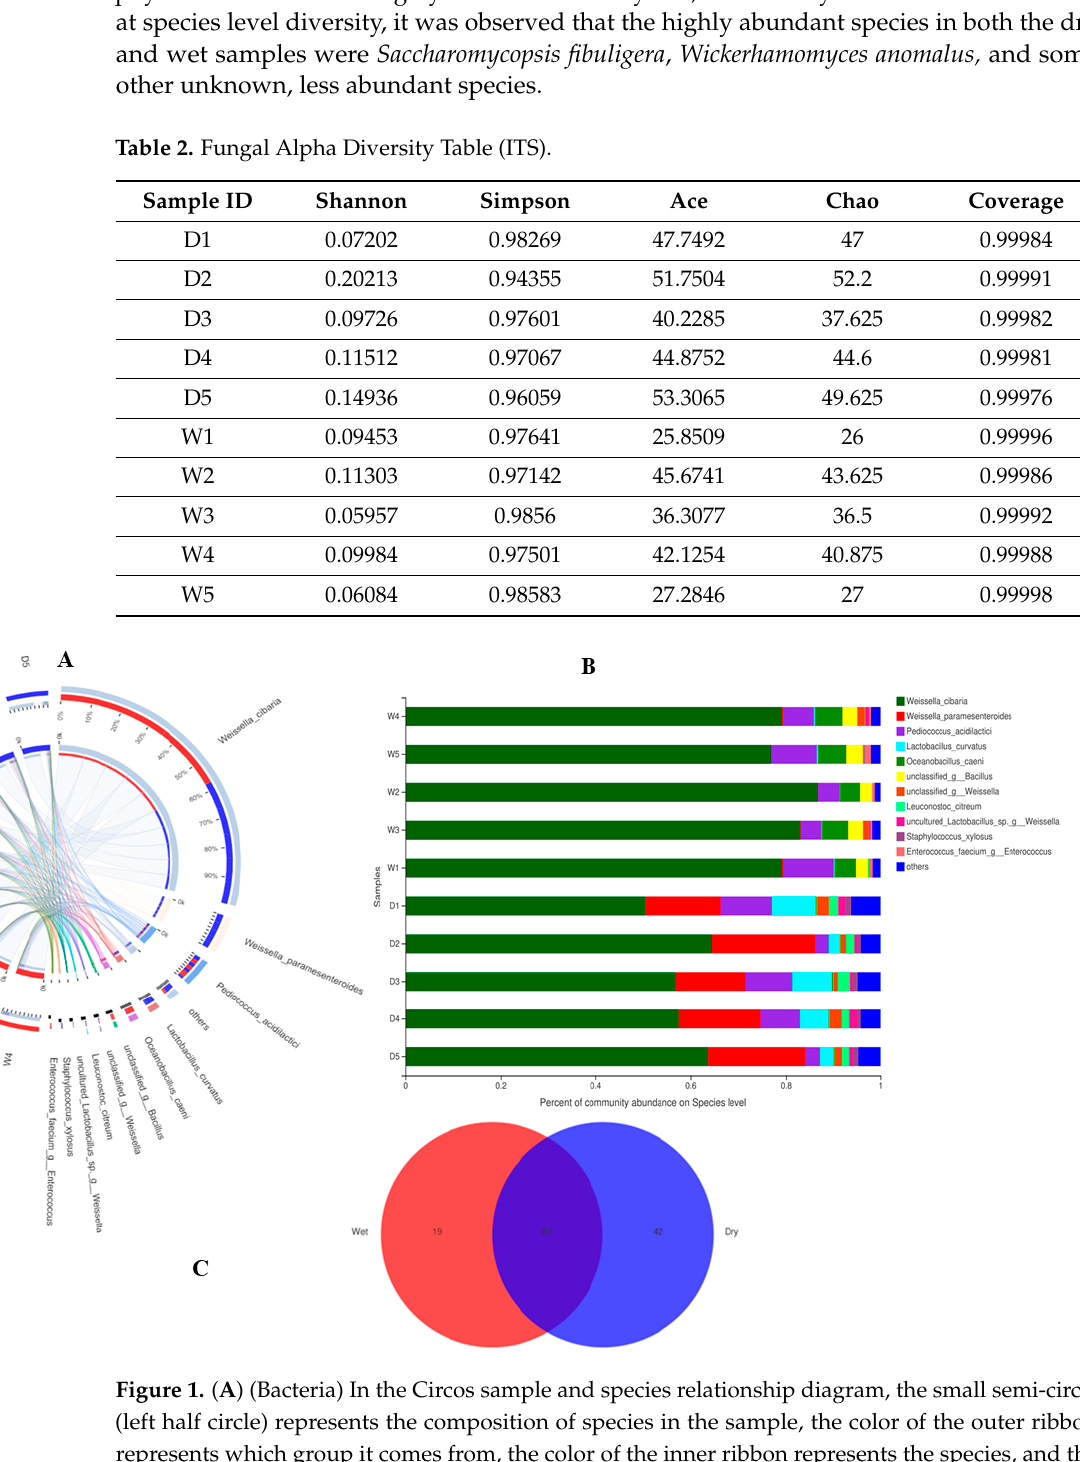
Table 2. Fungal Alpha Diversity Table (ITS).